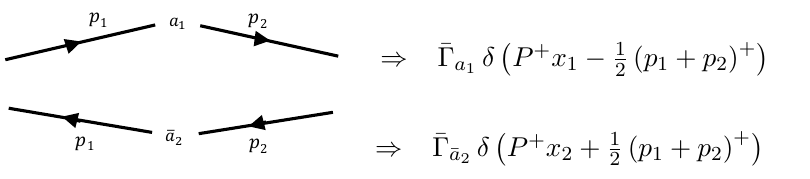
Table 1 . Bare vertices associated to the bilocal